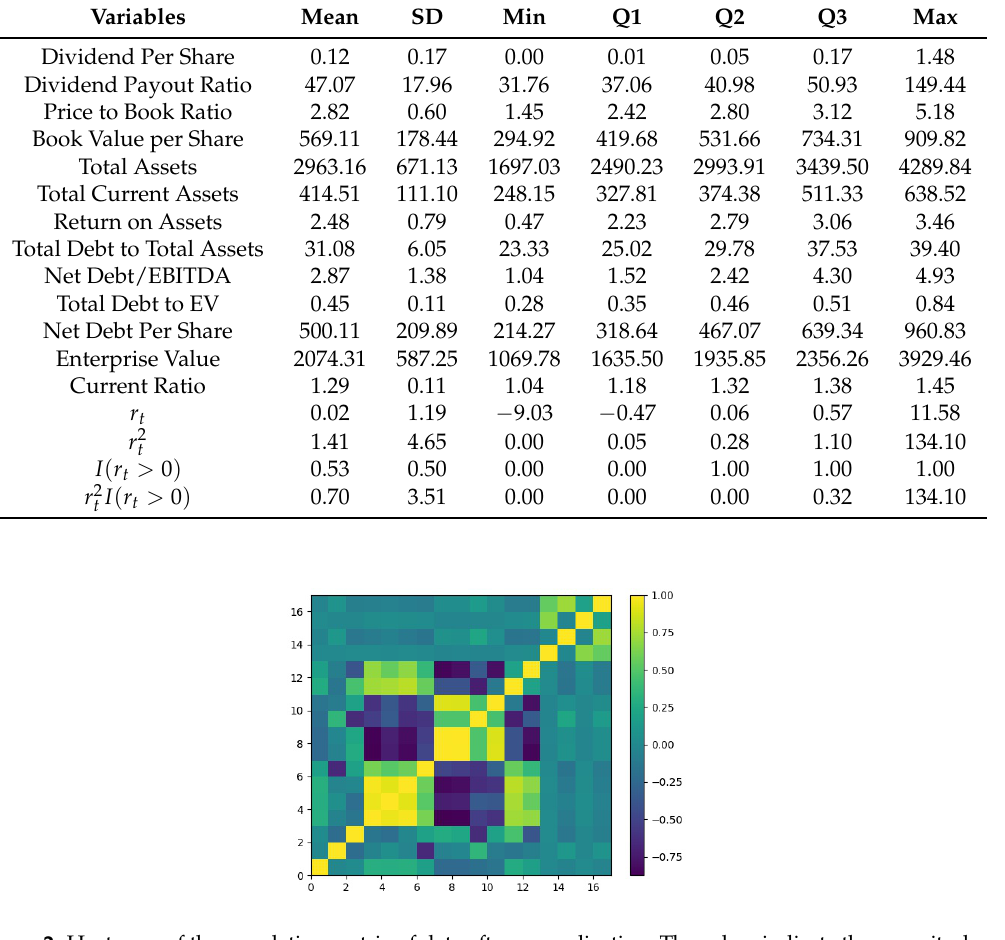
Table 1. Data summary, where Q1, Q2, Q3 refer to 25% quartile, median, and 75% quartile, respectively.